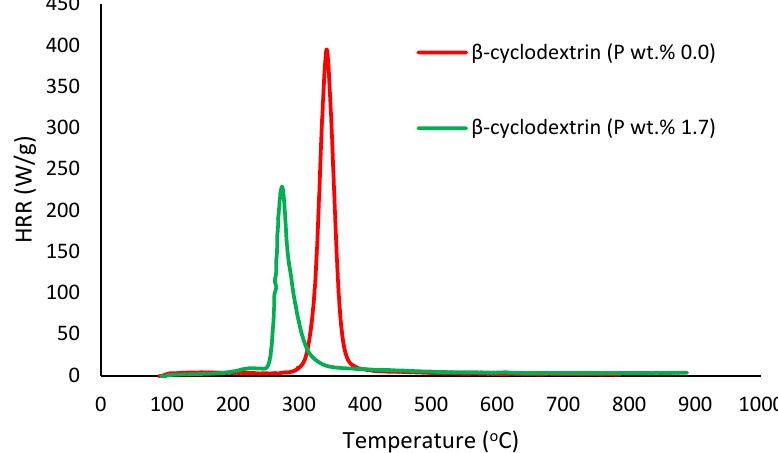
Figure 8. Plot of the heat release rate (HRR) (W / g) versus temperature ( ◦ C) for modified and unmodified versions of β -cyclodextrin.